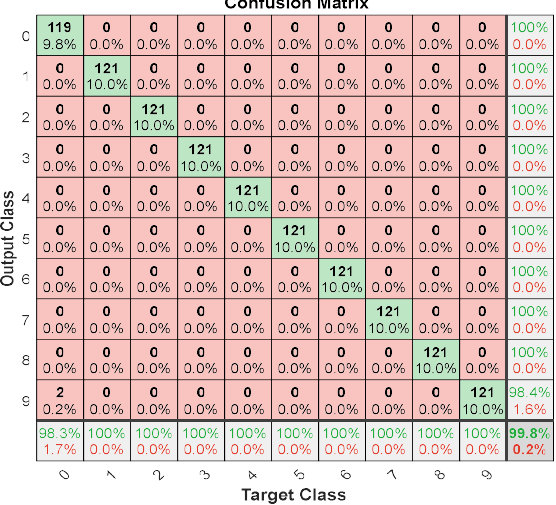
Figure 17. Accuracy and loss rate of FE for noisy LFM by CNN.